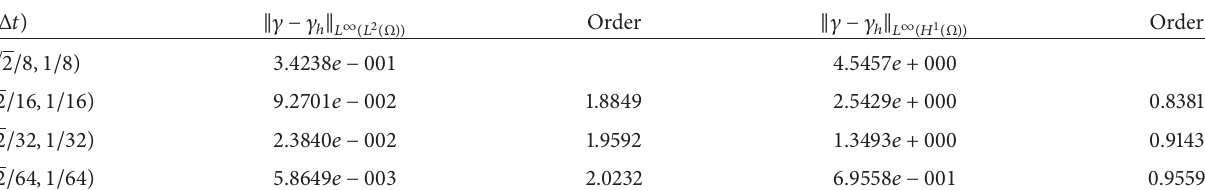
Table 2: 𝐿 2 and 𝐻 1 -norms and convergence order for 𝛾 .